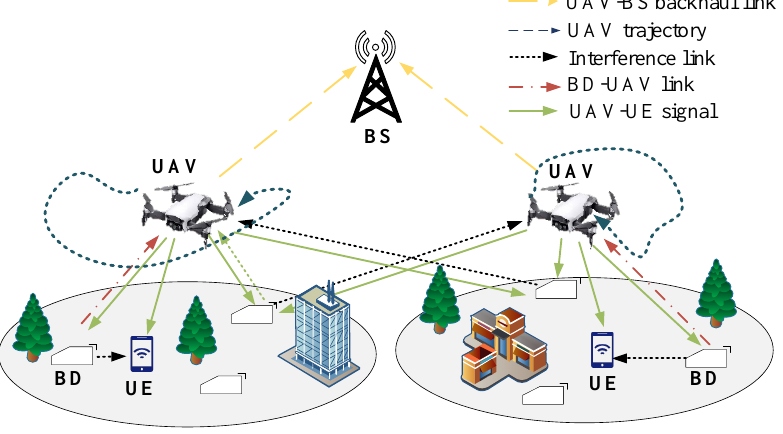
Figure 1. Multi-FD-UAV-assisted NOMA-enabled backscatter communication